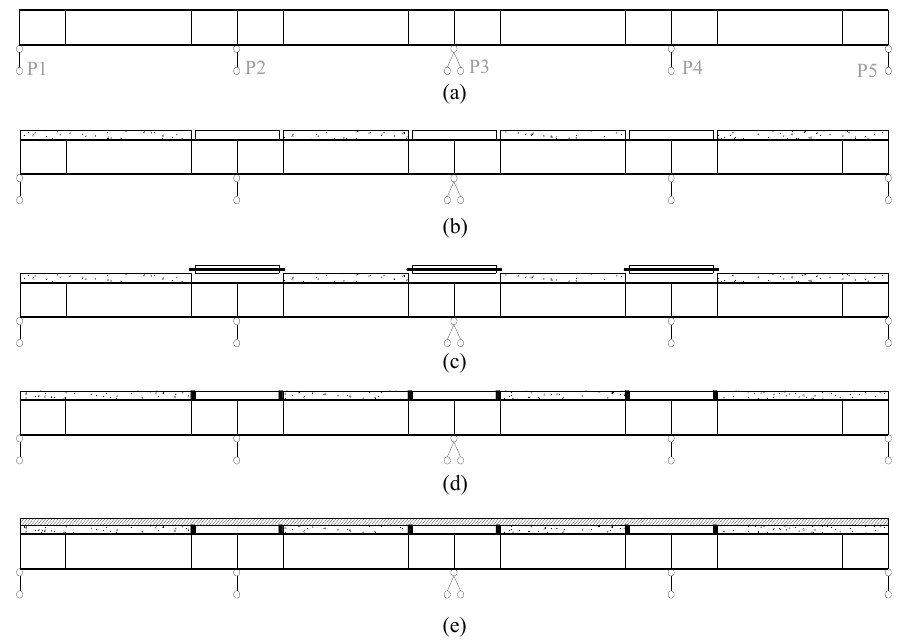
Figure 2. Construction sequence of the twin-I girder bridge: ( a ) Steel girder erection; ( b ) Precast concrete deck segments erection; ( c ) Prestressing concrete deck in the hogging regions; ( d ) Cast-in-place joints and void to connect girders and deck; ( e ) Constructed condition with the wearing surface and the attached appurtenance.